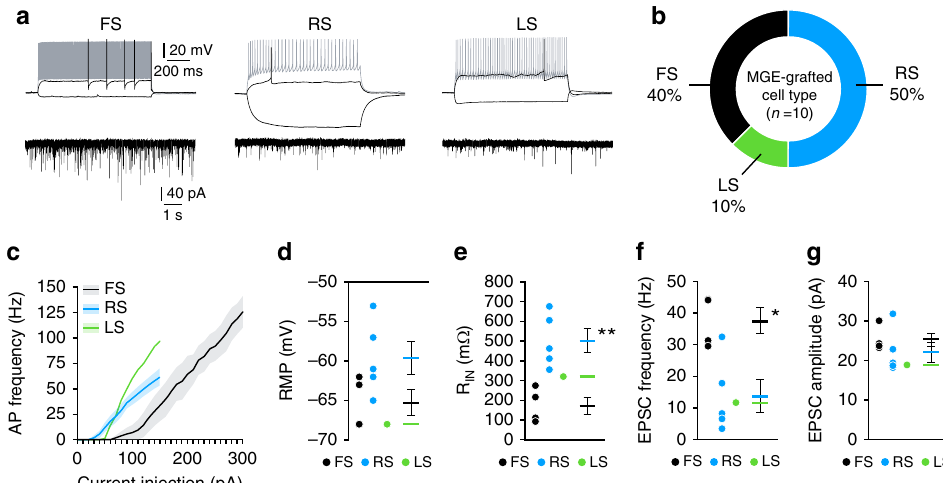
Fig. 2 Transplanted MGE cells integrate into brain injured hippocampus as mature interneurons. a Voltage responses of three transplanted MGE cells to a hyperpolarizing current pulse ( − 50 pA) and depolarizing current pulses near threshold (black) and maximal fi ring (gray). Holding potential was near − 70 mV. FS fast spiking, RS regular spiking, LS late spiking. Recordings were obtained from slices 45 – 60 DAT. Voltage-clamp recordings of EPSCs in each cell are shown below each current-clamp recording. b Occurrence of each interneuron subtype recorded based on fi ring properties ( n = 10 cells from 3 TBI- MGE mice). c Plot of action potential fi ring frequency (Hz) as a function of current intensity. d Quanti fi cation of resting membrane potential (RMP) for each cell type. e Quanti fi cation of R input for each cell type. ** P = 0.004, FS vs RS, two-tailed t -test. f , g Mean EPSC frequency ( f ) and amplitude ( g ) according to interneuron subtype. * P = 0.01, FS vs RS, two-tailed t -test. Error bars, s.e.m. Source data are provided as a Source Data fi le